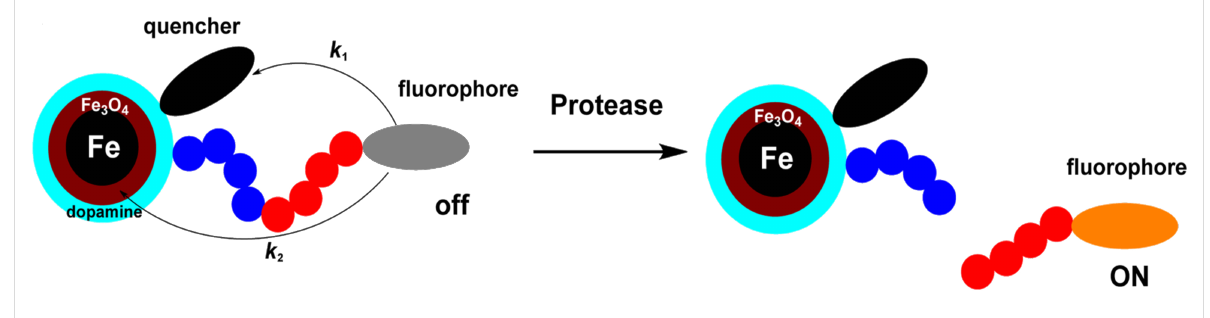
Figure 2: Mechanistic scheme of the “light switch effect” upon proteolytic cleavage: the fluorophore is switched on due to the increase in distance be- tween the Fe/Fe 3 O 4 core/shell nanoparticle, leading to decreased Förster resonance energy transfer (FRET) [21,24], k 1 , and dipole–surface energy transfer (SET) [20,22], k 2 . Further explanations are provided in the text.